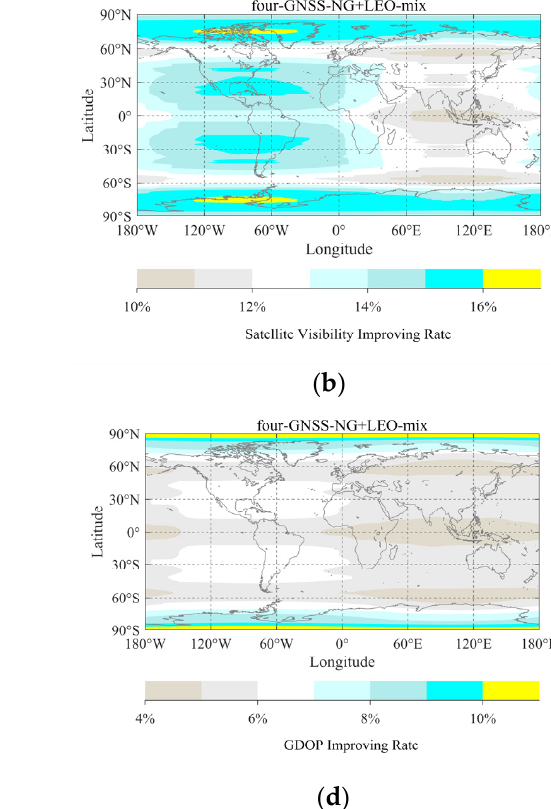
Table 6. Constellation parameters of QZSS and NavIC. System